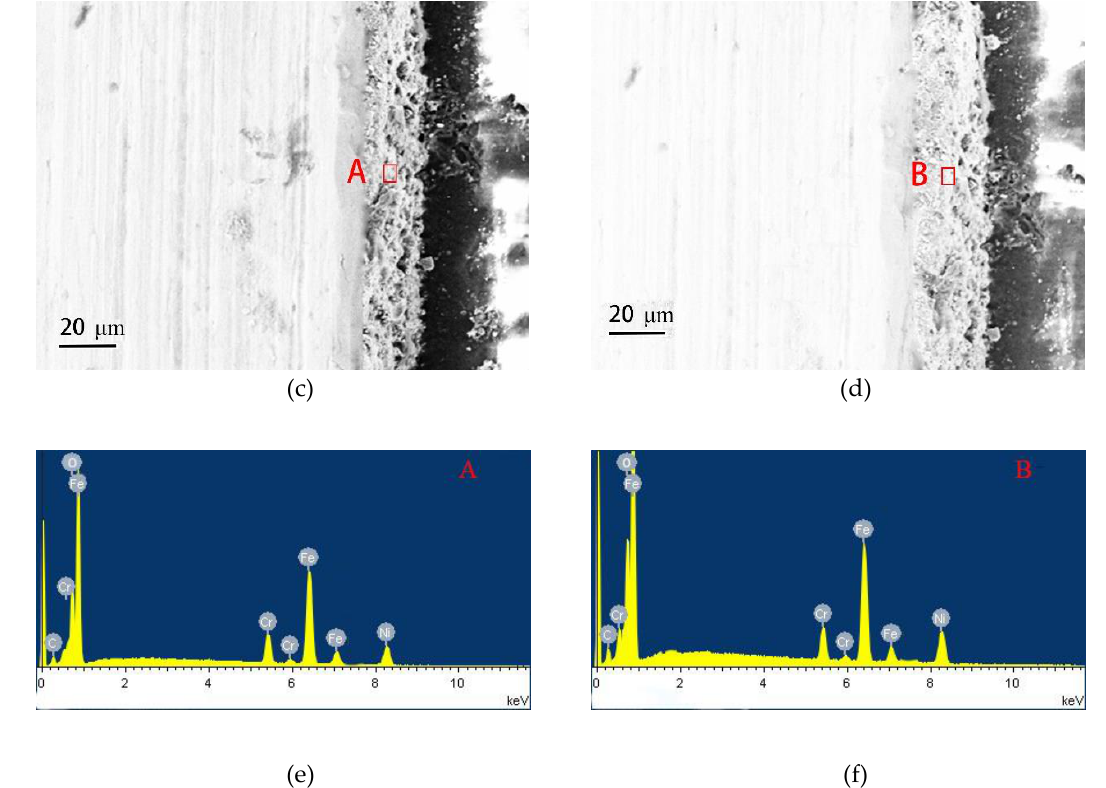
Figure 6. Cross-sectional morphologies of SMA490BW steel ( a ) 75 h, ( c ) 150 h, and ( e ) EDS and welded joints ( b ) 75 h, ( d ) 150 h, and ( f ) EDS after the periodic immersion wet/dry cyclic corrosion test.